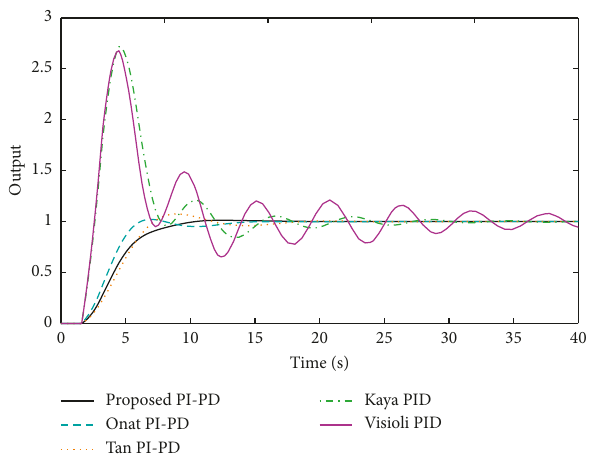
Figure 4: Unit step responses comparison of various methods for example A.